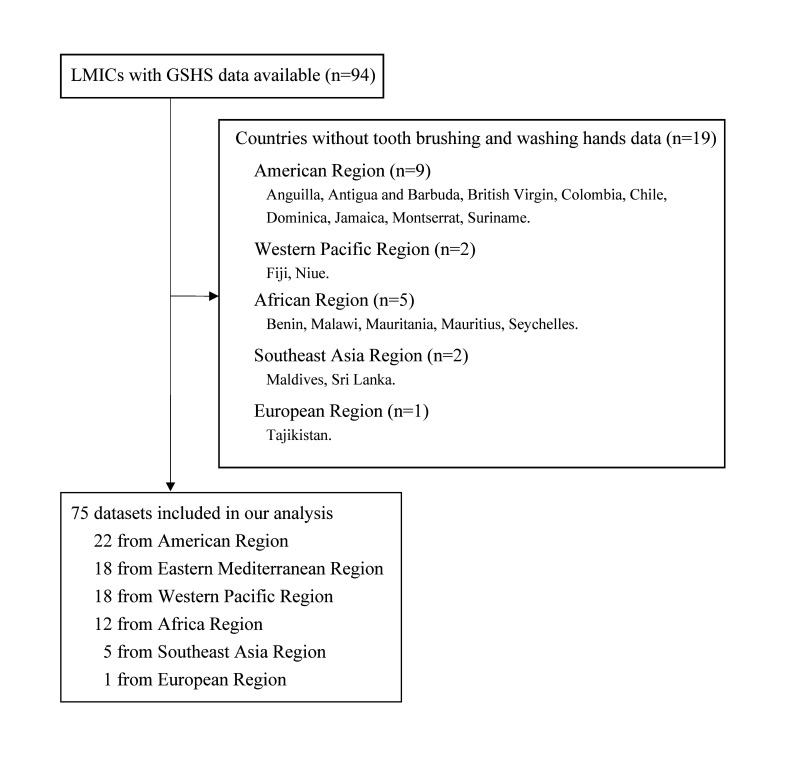
Flow of participants through the study.